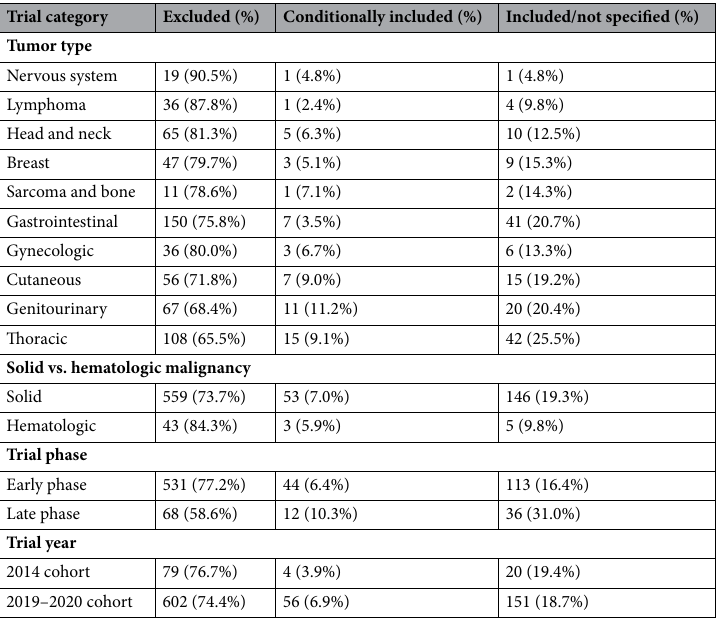
Table 1. Number and percentage of cancer immune checkpoint inhibitor trials excluding, conditionally including, or including/not specifying patients living with